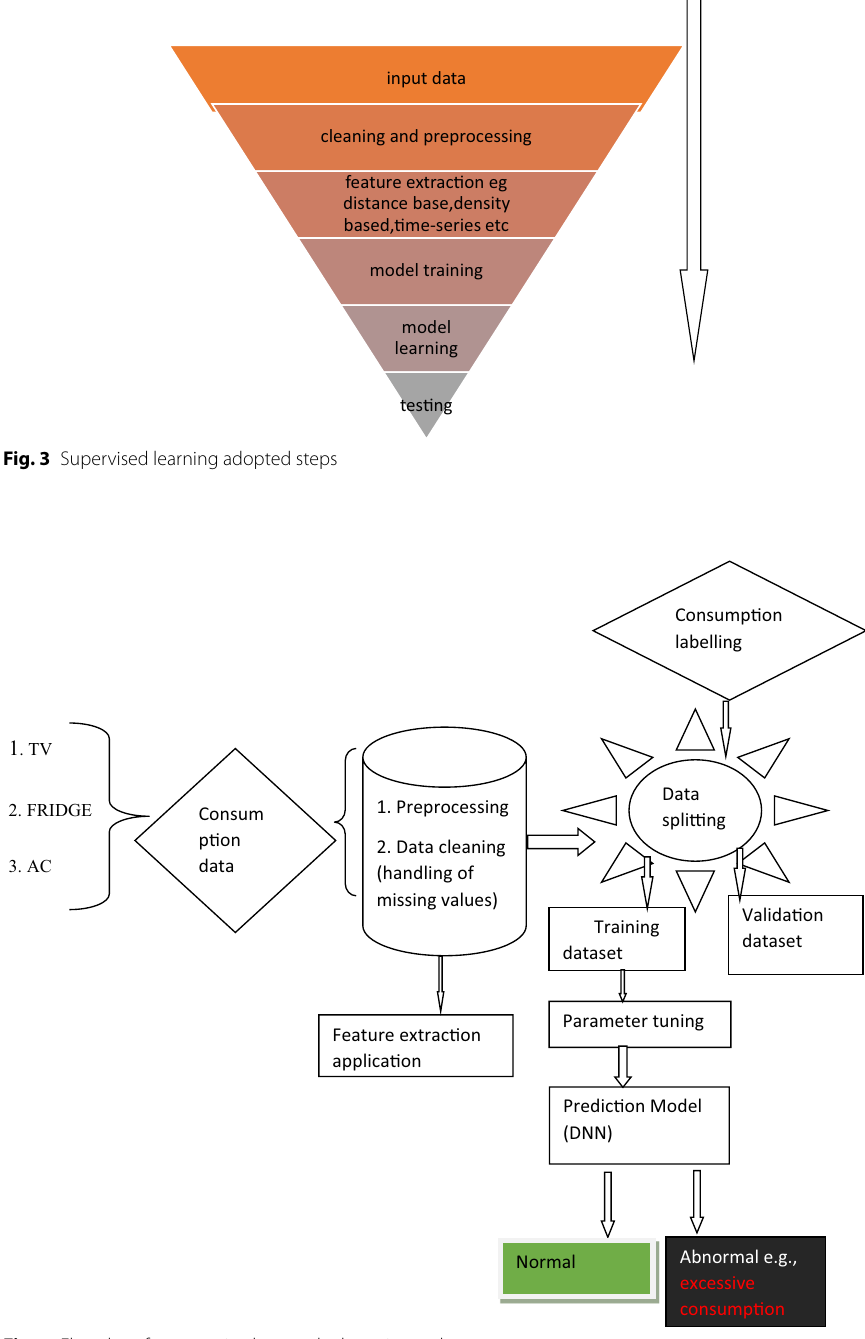
Fig. 4 Flowchart for supervised anomaly detections